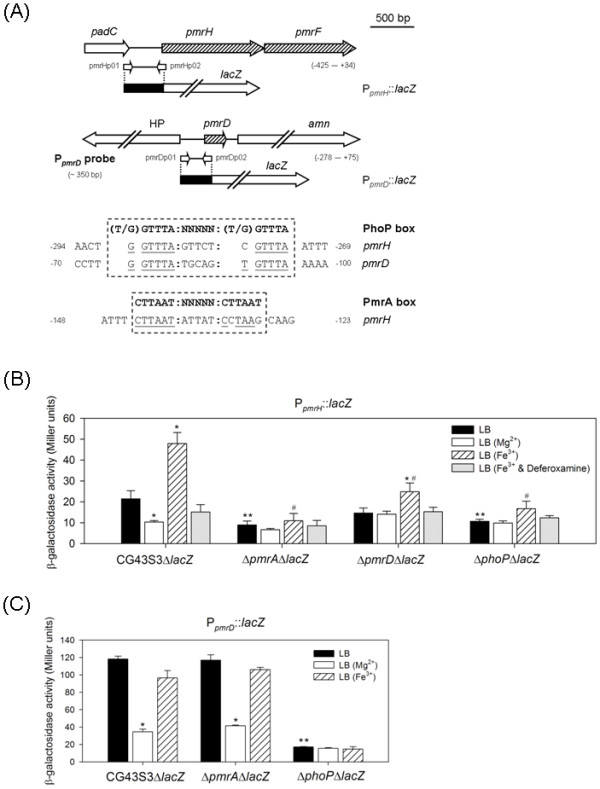
Schematic representation of pmrH and pmrD loci and determination of K. pneumoniae PpmrH::lacZ and PpmrD::lacZ activity. (A) Diagrammatic representation of the pmrH and pmrD loci. The large arrows represent the open reading frames. The relative positions of the primer sets used in PCR-amplification of the DNA fragments encompassing the PpmrH and PpmrD regions are indicated, and the numbers denote the relative positions to the translational start site. The name and approximate size of the DNA probes used in electro-mobility shift assay (EMSA) are shown on the left. The dashed boxes indicate the predicted PhoP and PmrA binding sequences and the alignment result is shown below. The identical nucleotide sequences are underlined. HP, hypothetical protein. (B) The β-galactosidase activities of log-phased cultures of K. pneumoniae strains carrying placZ15-PpmrH grown in LB, LB containing 10 mM MgCl2, LB containing 0.1 mM FeCl3 or 0.1 mM FeCl3 plusing 0.3 mM deferoxamine were determined and expressed as Miller units. (C) The β-galactosidase activities of log-phased cultures of K. pneumoniae strains carrying placZ15-PpmrD grown in LB, LB containing 10 mM MgCl2 or LB containing 0.1 mM FeCl3 were determined and expressed as Miller units. The data shown were the average ± standard deviations from triplicate samples. *, P < 0.01 compared to the same strain grown in LB medium. **, P < 0.01 compared to the parental strain grown in LB medium. #, P < 0.01 compared to the parental strain grown in LB medium supplemented with ferric ions.